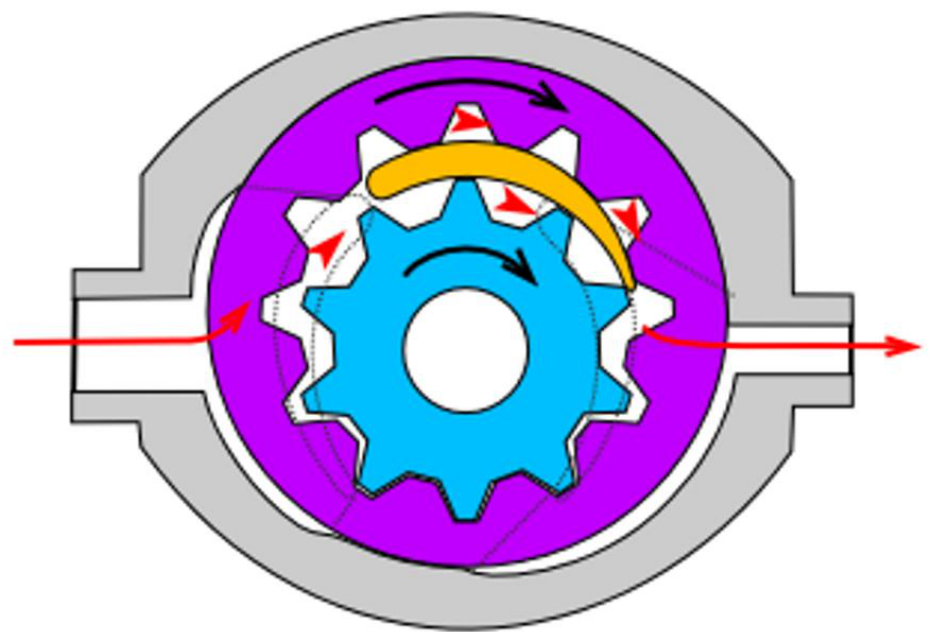
Figure 1. Internal gear pump (crescent type) design scheme. Red arrows present the pathway of the pumped medium, the black ones—the rotation direction of the gears. Source: https://commons.wiki-